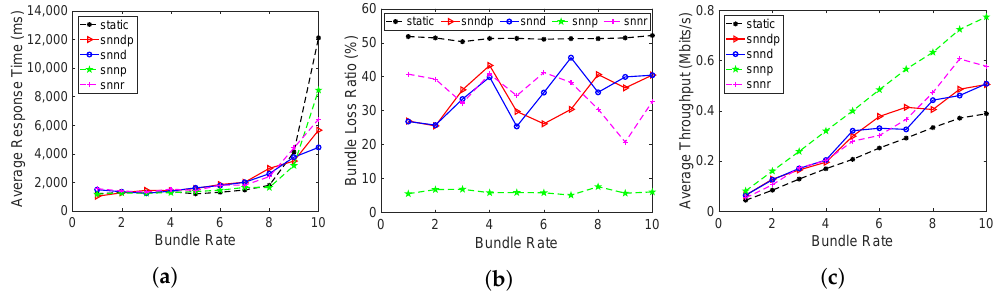
Figure 5. Routing performance: Scenario 2. ( a ) Average response time; ( b ) Packet loss ratio (%); ( c )